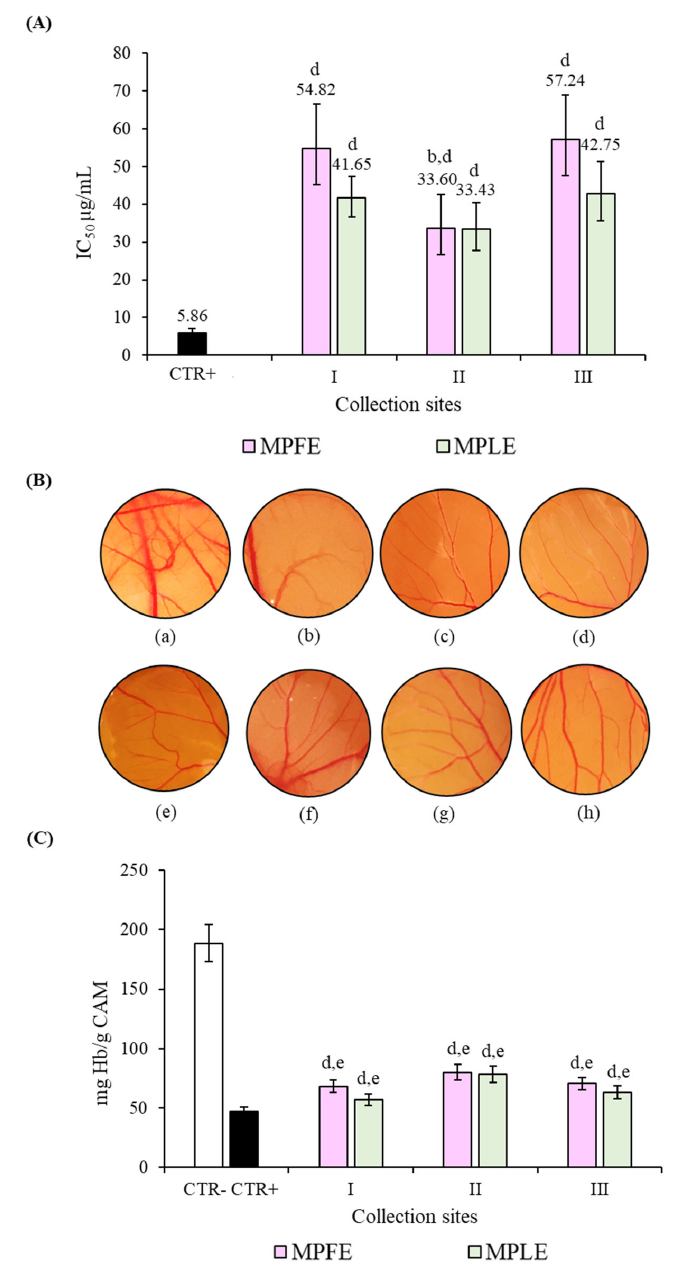
Figure 8. Antiangiogenic activity of leaf and flower extracts of M. pulegium (MPLE and MPFE, respectively) investigated by chick chorioallantoic membrane (CAM) assay. ( A ) Antiangiogenic activity expressed as half ‐ maximal inhibitory concentration (IC 50 ) of vascular density with respective confident limits (C.L.) at 95%. ( B ): Representative pictures of the CAM treated with CTR ‐ (( a ) ethanol/water 70:30); CTR+ (( b ) retinoic acid 10 μ g/mL); MPLE I (( c ) 80 μ g/mL), MPLE II (( d ) 40 μ g/mL), MPLE III (( e ) 80 μ g/mL), MPFE I (( f ) 80 μ g/mL), MPFE II (( g ) 40 μ g/mL) and MPFE III (( h ) 80 μ g/mL) and evaluation of the respective hemoglobin content ( C ). a p < 0.001 vs. respective MPLE; b p < 0.001 vs. other MPFE; c p < 0.001 vs. other MPLE d p < 0.001 vs. CTR+; e p < 0.001 vs. CTR ‐ .